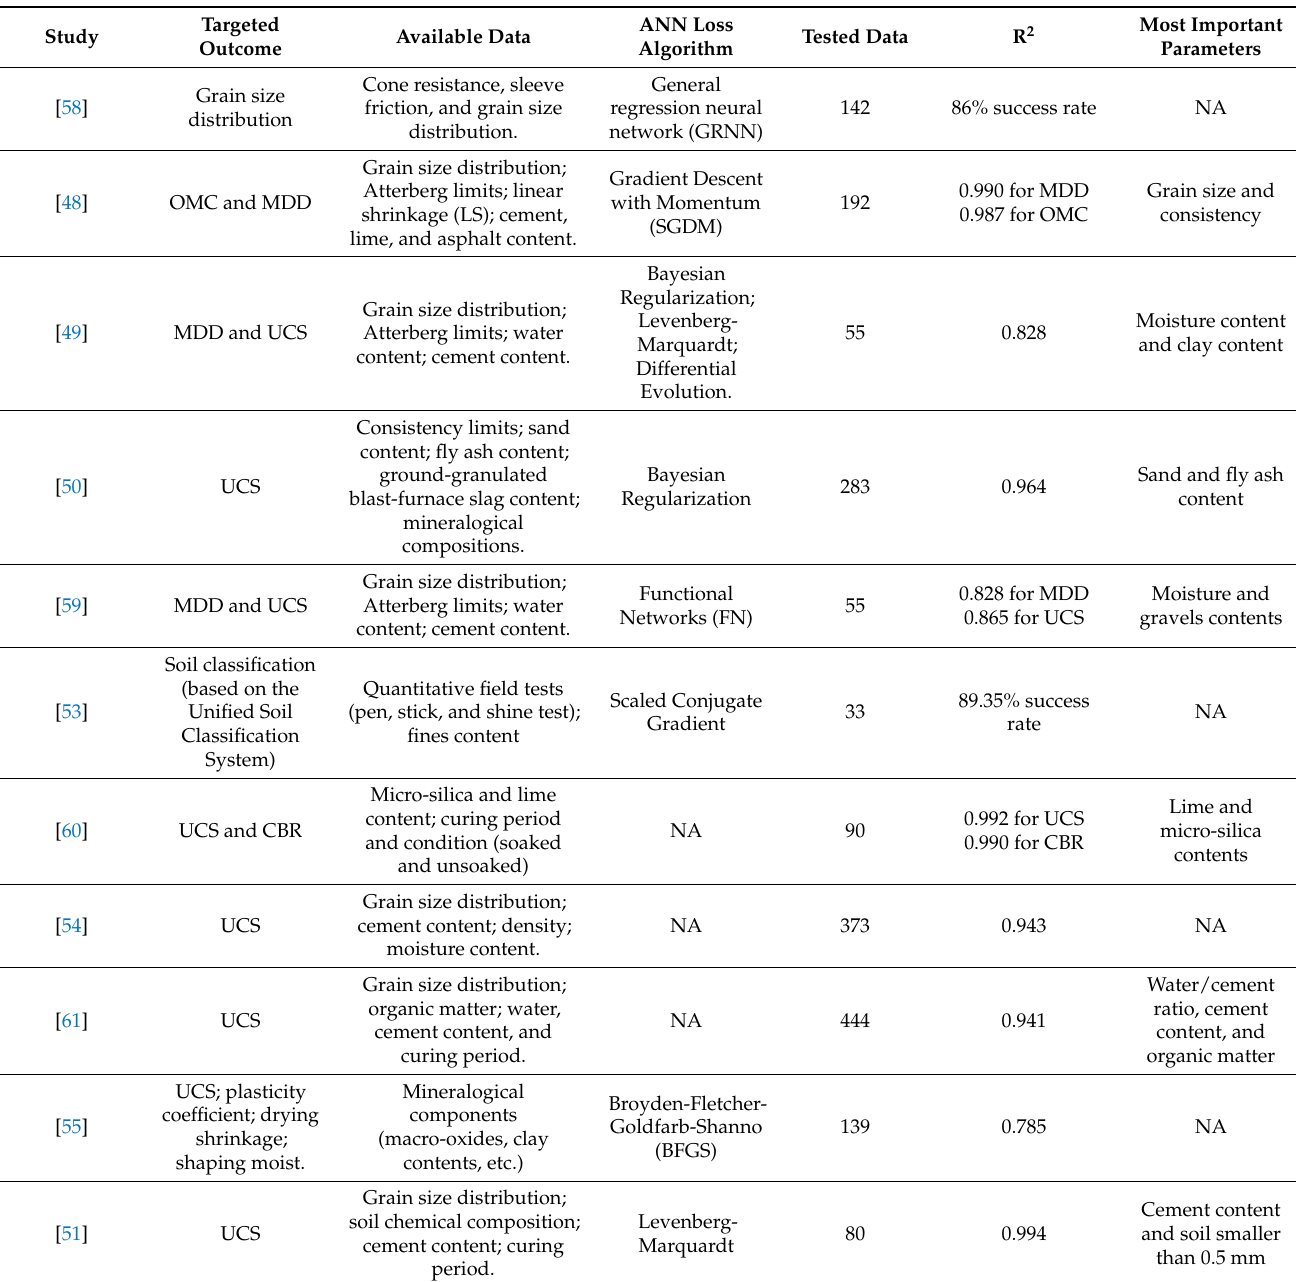
Table 2. Summary of some neural network studies focusing on soil characteristics and strength (Compiled by the